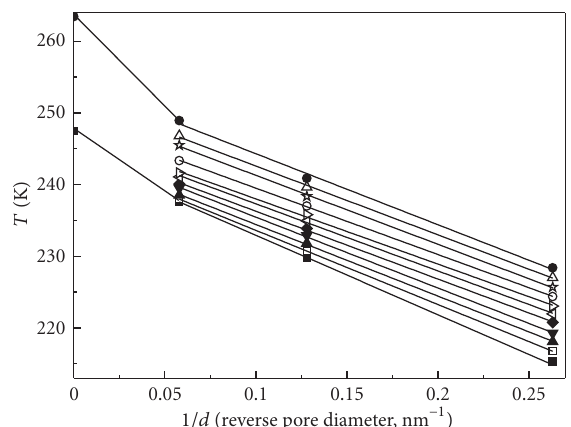
F 10: Melting points of pure (C